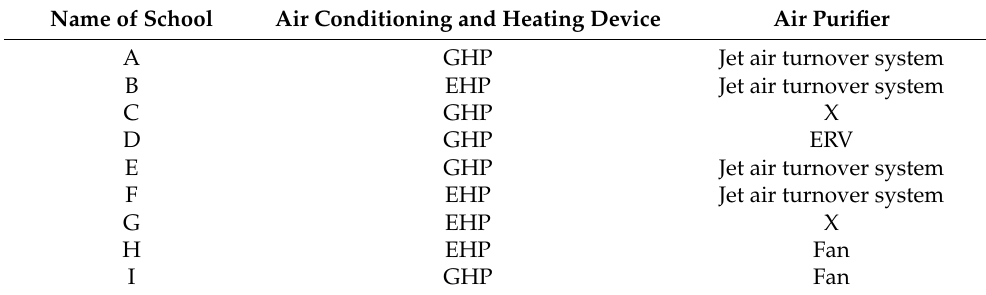
Table 3. Status of the air conditioners and air purifiers in the analyzed elementary schools. Name of School